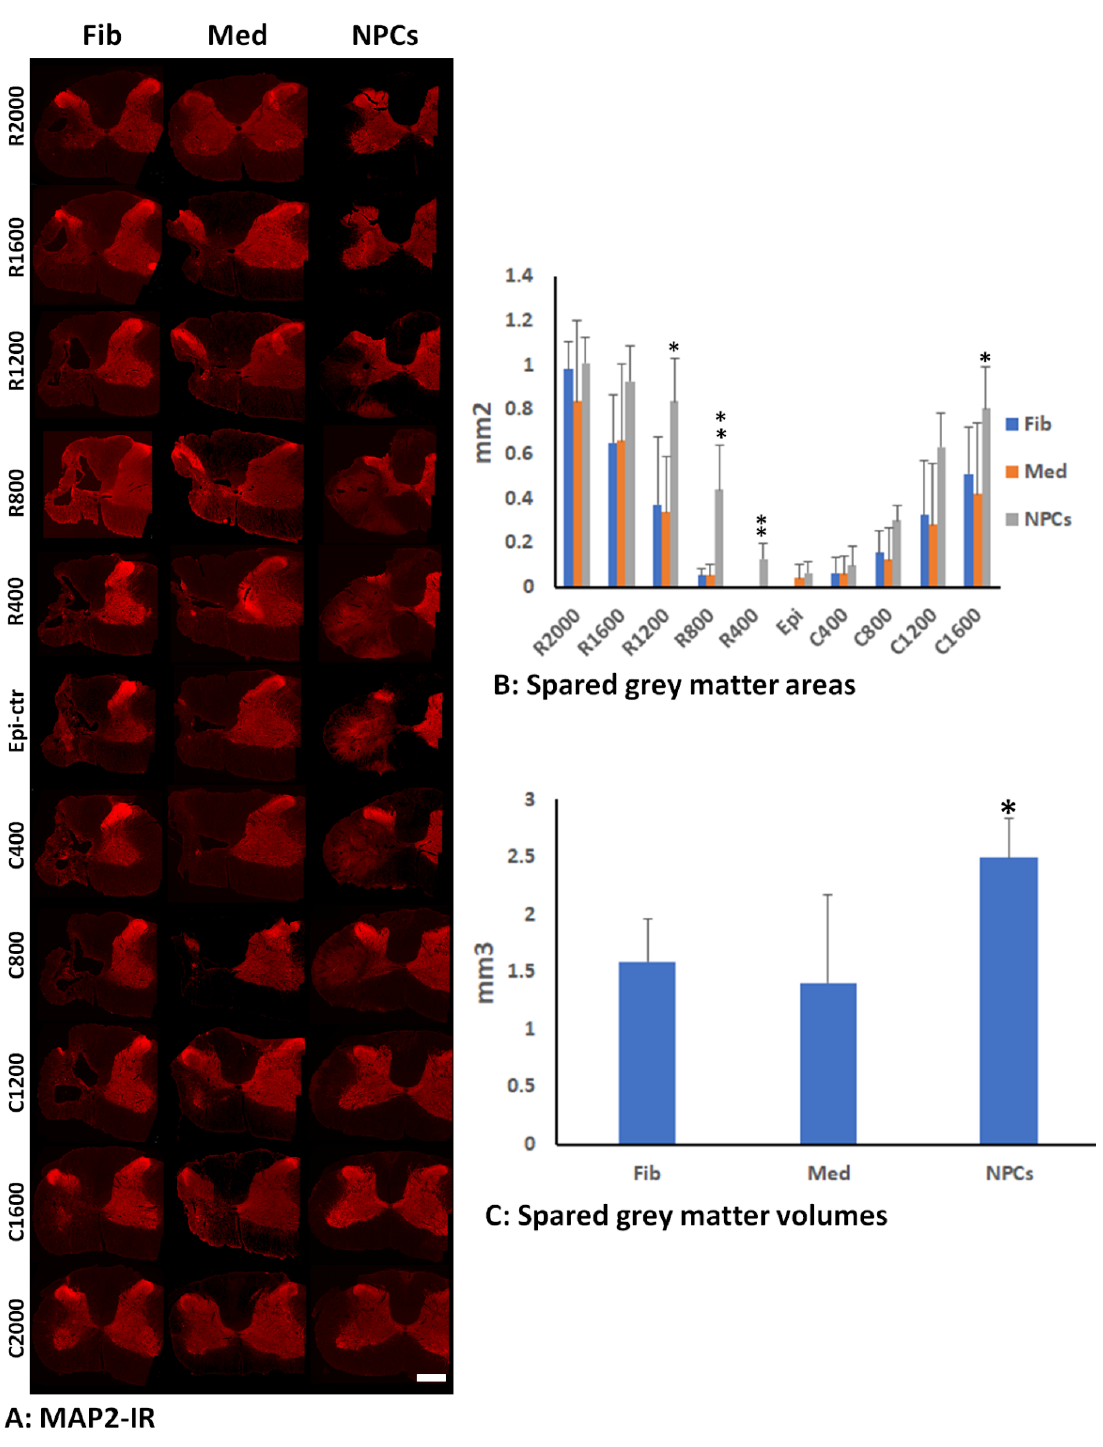
Figure 5. Spared gray matter after transplantation of hiPSC-NPC. Spared gray matter (GM) in the injured side was quantified using MAP2 immunohistochemistry at 2 months after transplantation ( A ). The spared GM areas were significantly greater in rostral 0.4, 0.8, and 1.2, or caudal 1.6 mm from injury epicenter, respectively, in rats receiving NPC grafts compared to groups receiving human fibroblasts or culture medium ( B ). The total spared GM volume in the injury side was also significantly greater in NPC grafting group compared to other two groups ( C ). Scale bar: A, 500 μ m. Data in ( B , C ) represent the man ± SD (n = 5). * in ( B , C ), p < 0.05; ** in ( B ), p < 0.01.